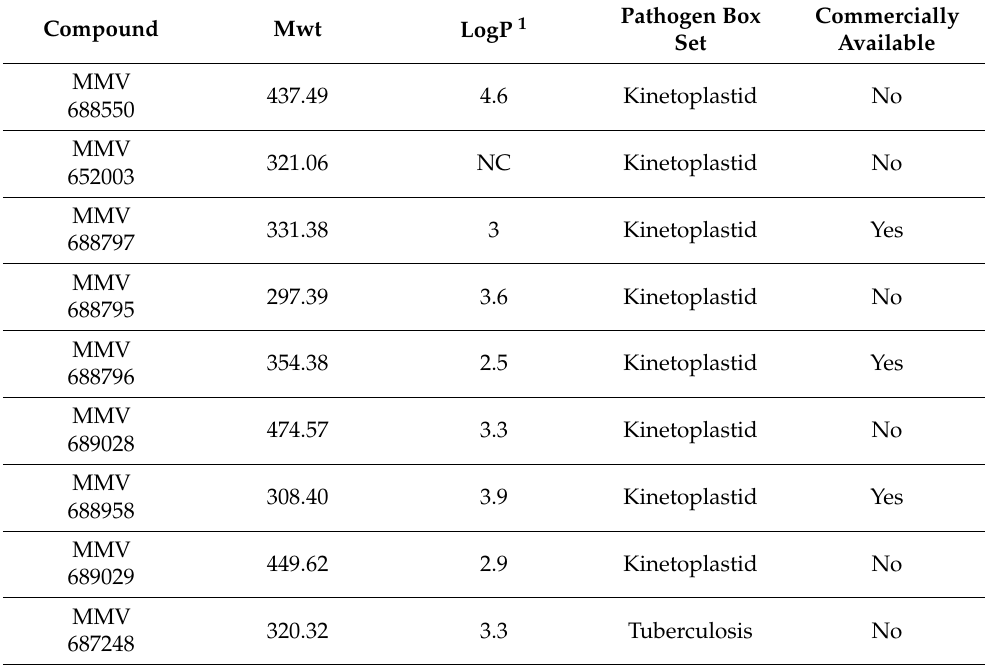
Table 4. Physicochemical properties of fast-acting Pathogen Box compounds with activity against T.b. brucei and T. cruzi .